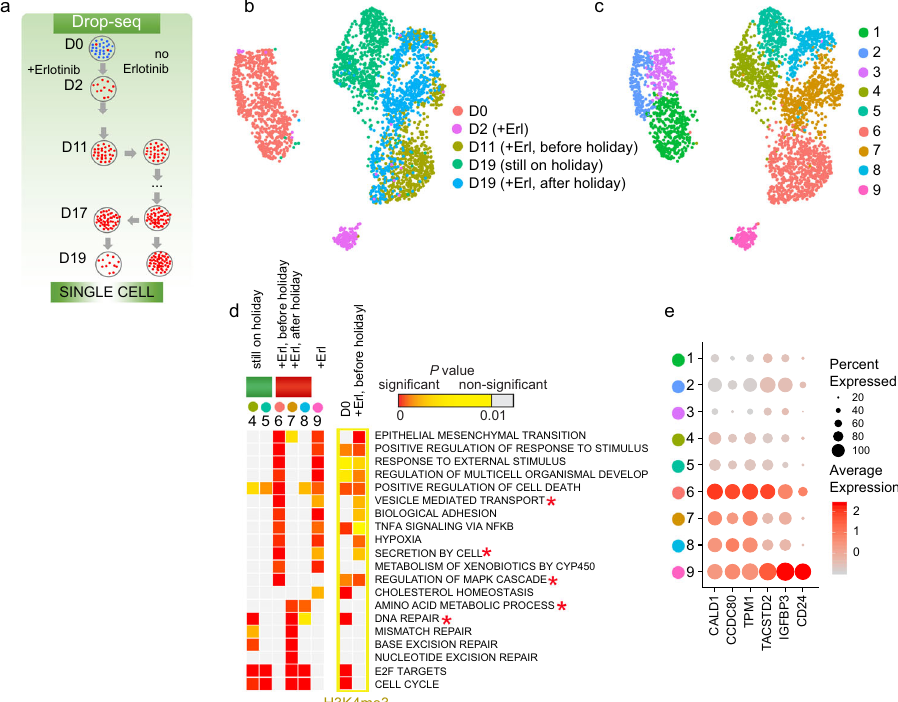
Fig. 2 Resuming treatment after drug holiday restores tolerant cell populations and their markers. a Schematics of drug holiday treatment for scRNA- seq. b UMAP representation of cells colored by days of treatment. c UMAP representation of cells colored by clusters. d Enrichment analysis for genes in relation to gene ontology (GO) biological process (BP), hallmark gene sets, or Kyoto encyclopedia of genes and genomes (KEGG) pathways (MSigDB Collections) is shown for top cluster markers ( P < 0.05). To reveal signi fi cance of enrichment of the identi fi ed gene set signatures at the level of whole cell population, bulk ChIP-seq data and bulk RNA-seq were used to analyze upregulated genes with increased H3K4me3. Data is shown for large gene sets (>20 genes), with at least 10 markers in one DT cluster, P < 10 − 5 , and at least 10 − 3 difference with untreated condition. Data represents right tail P values, two-sided binomial statistical test, adjusted for multiple testing using Benjamini – Hochberg FDR method. P values are delineated in a colored heatmap where color-coding indicates the degree of signi fi cance: highest signi fi cance (red) to least signi fi cance (yellow) and non-signi fi cant (gray). Terms that were discussed in the main text are indicated by asterisks. e Dot plot of expression for selected